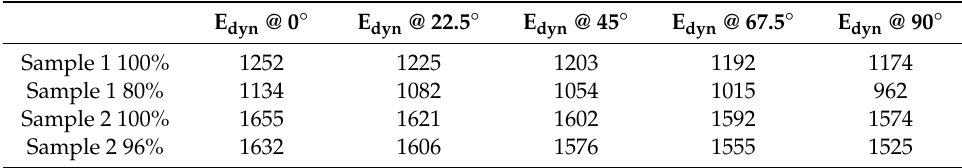
Table A1. Summarized angle-dependent dynamic Young’s modulus values in